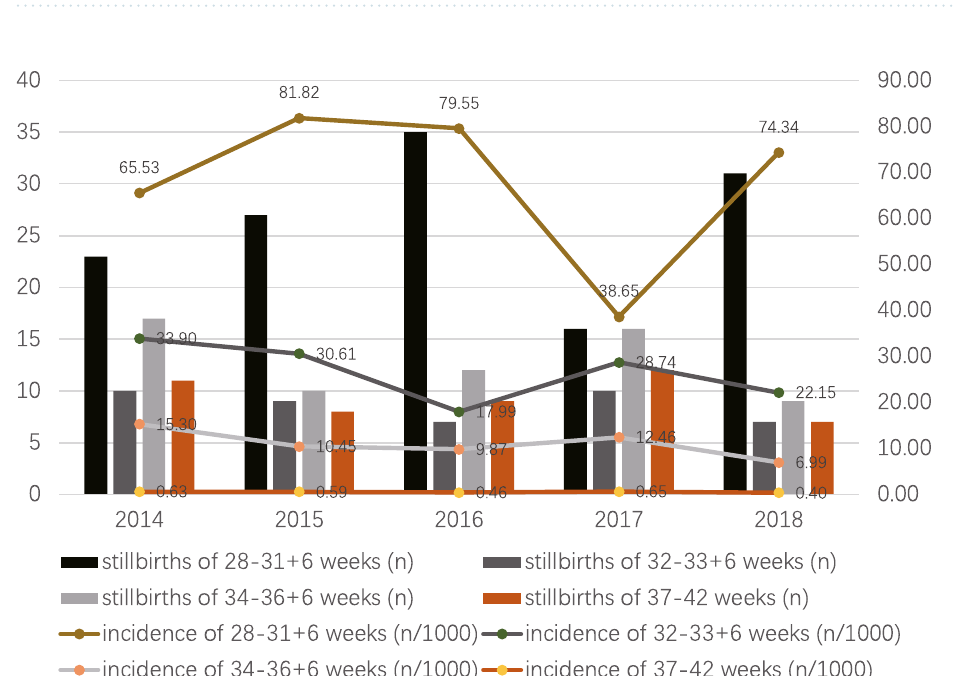
Figure 2. Incidence of third-trimester stillbirths in different years.